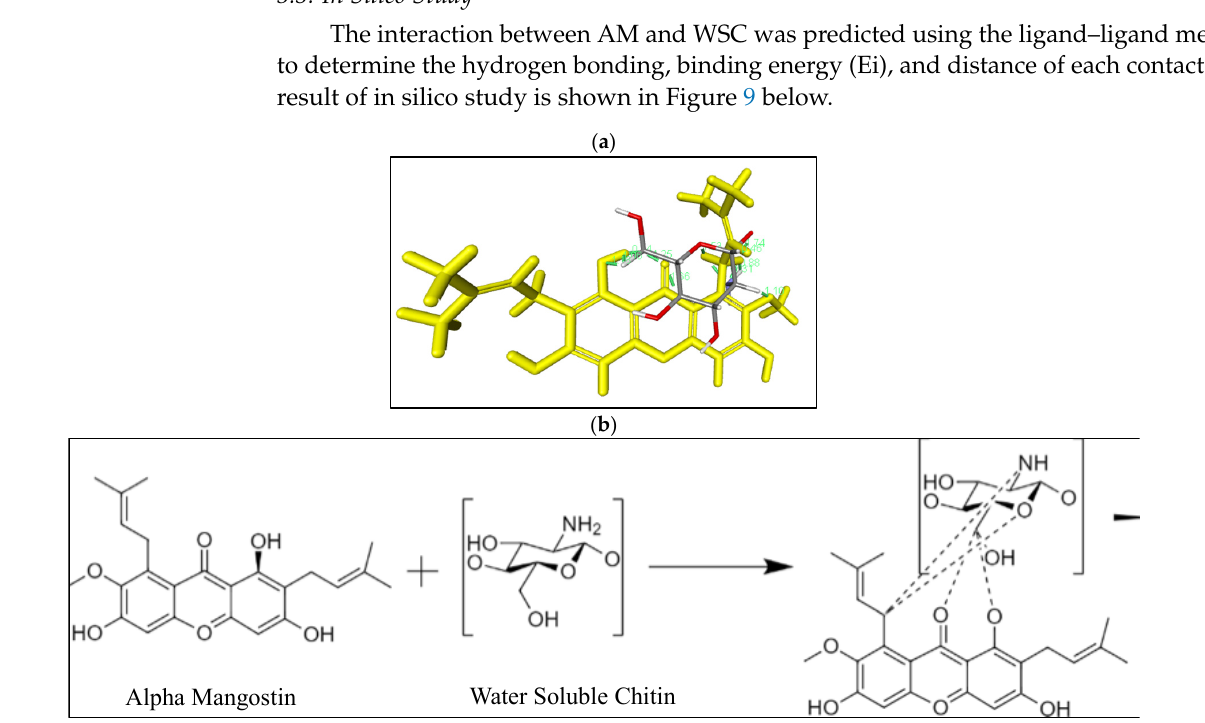
Figure 9. ( a ) Three-dimensional and ( b ) two-dimensional visualization of alpha-mangostin (AM) with water-soluble chitosan (WSC).